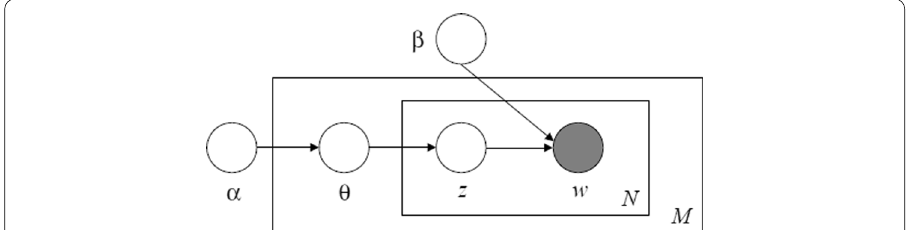
Fig. 1 Graphical representation model of the